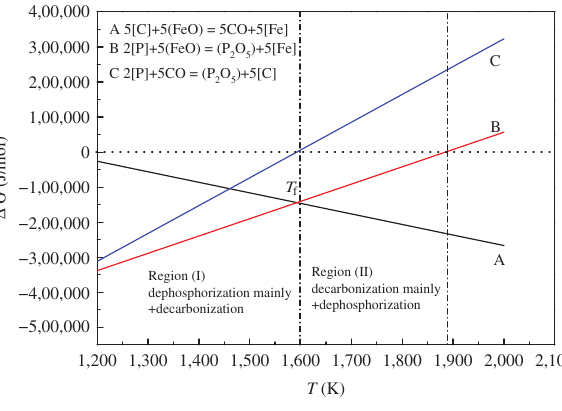
Figure 2: Gibbs free energy as a function